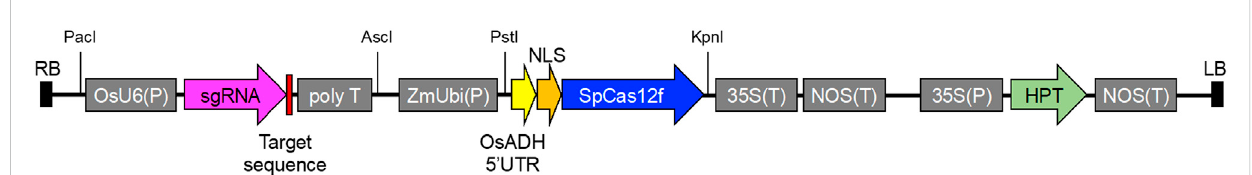
FIGURE 1 Vector construction of pPZP-SpCas12f Tub-1 and pPZP-SpCas12f Tub-2. Vector carrying sgRNA for OsTub-1 or OsTub-2 under the control of the riceU6promoterOsU6(P),rice-codonoptimizedNLS-SpCas12fgeneunderthecontrolofthemaizeubiquitin1promoterZmUbi(P),andthehygromycin phosphotransferase gene under the control of the cauli fl ower mosaic virus 35S promoter 35S(P)as a selection marker. To enhance SpCas12f translation, the 5 ′ untranslated region of rice alcohol dehydrogenase (OsADH) was used. LB and RB; left and right borders of T-DNA, respectively; NLS, nuclear localization signal; 35S(T), cauli fl ower mosaic virus 35S terminator; NOS(T), nopaline synthase terminator; HPT, hygromycin